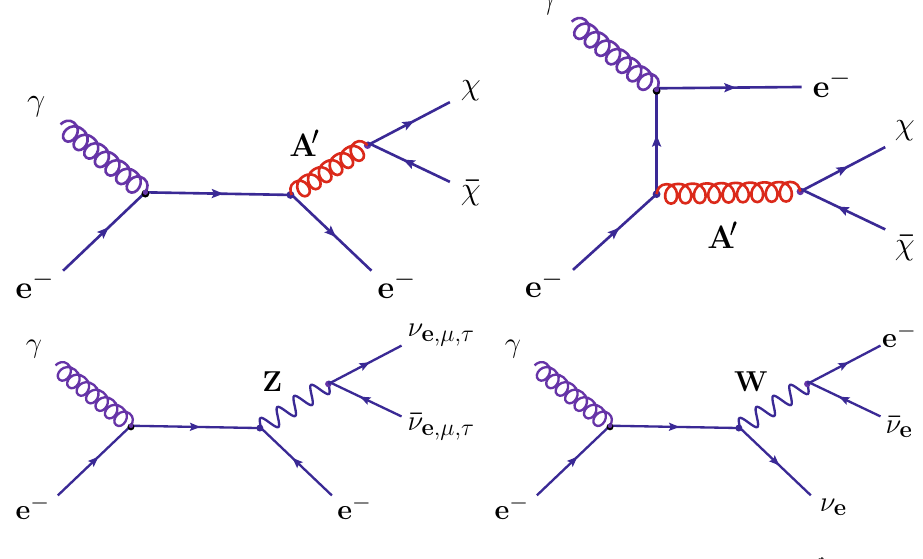
Fig. 4 The s -channel diagrams for the SM process γ e − → e − + E